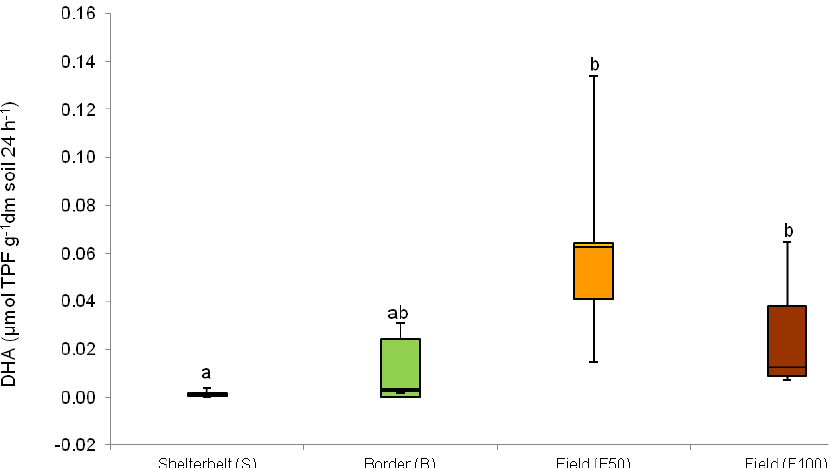
Figure 5 . Box plots and results of one-way ANOVA showing the effect of soil use on DHA activity level along the measurement transect. The top hanging bar represents the high edge, and the lower hanging bar is the lower edge; − m edian; □ quartile 25–75%; significant difference at p < 0.05; n = 9; different letters indicate significant differences.